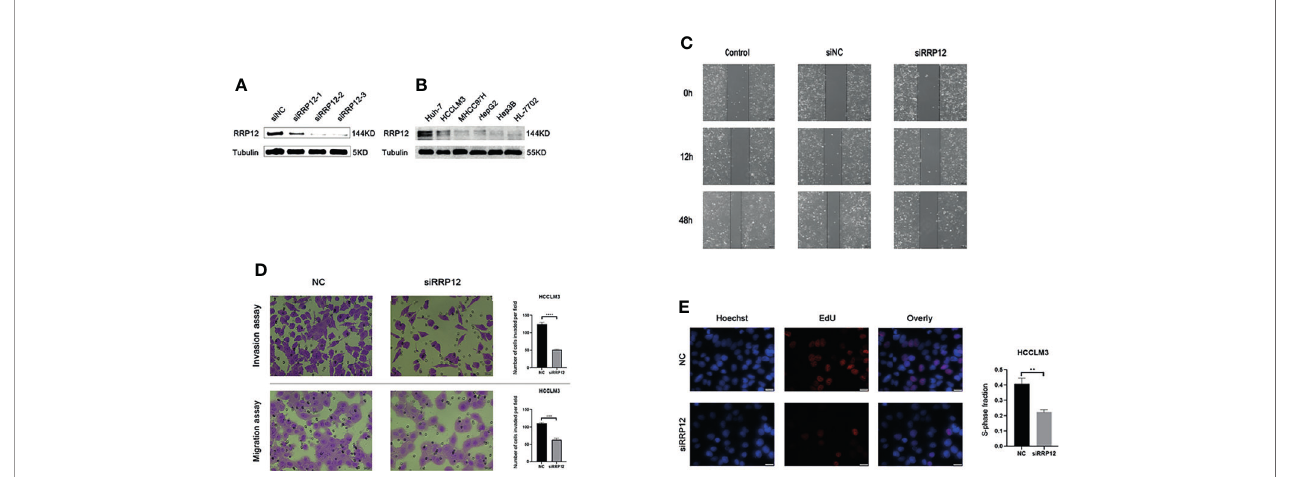
FIGURE 8 | (A) Knockdown the expression of RRP12 in HCCLM3 cells, and NC was the negative control group. (B) The expression of RRP12 in Hepatocellular carcinoma Cell Lines and normal liver cell line.HCCLM3 and Huh-7 cells are higher than other HCC cells. (C) The scratch distance of the siRRP12 group did not change signi fi cantly, while the scratch distance of the control and siNC group was reduced signi fi cantly. It showed that Knockdown of RRP12 expression inhibits HCC invasion and migration in vitro . (D) The number of cells in the siRRP12 group was less than the NC group in the transwell assay (p<0.01), and the NC group was the negative control group. (E) Knockdown of RRP12 expression inhibits HCC proliferation in vitro . The number of proliferating cells in the siRRP12 group was less than that in the NC group, and the NC group was the negative control